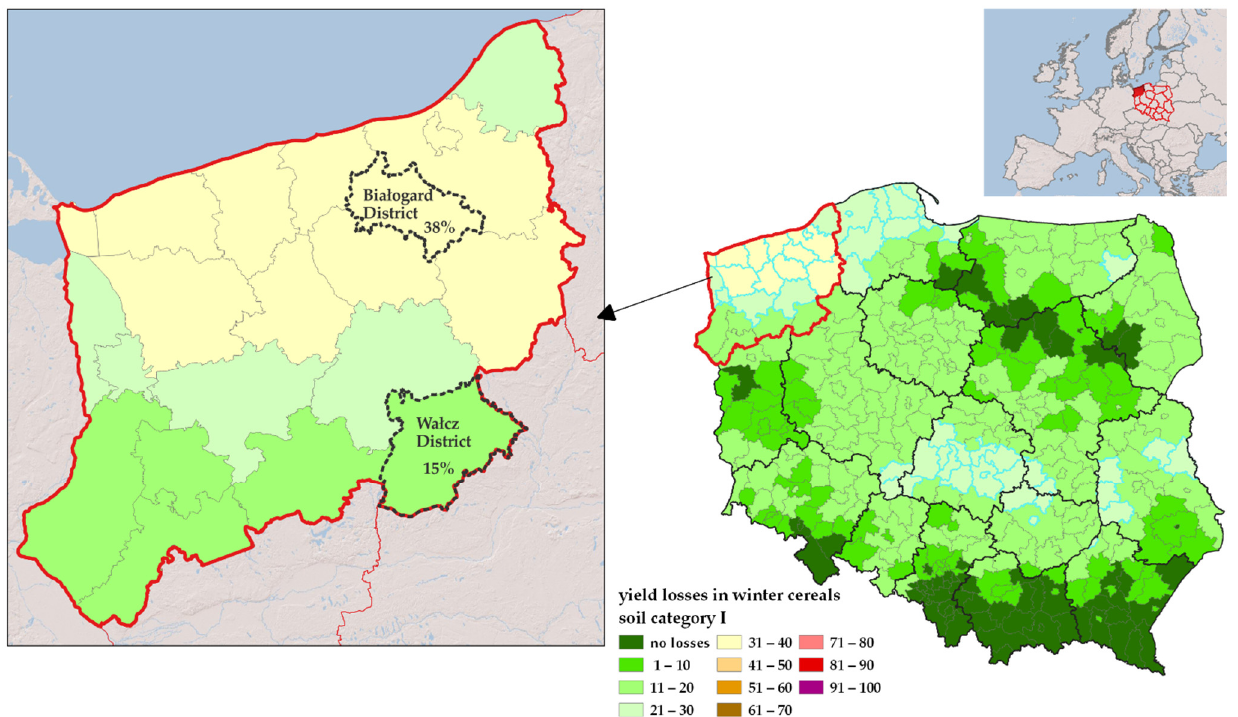
Figure 3. ADMS Map of estimated yield losses of winter cereals caused by drought—average losses on soils of the 1st category of susceptibility to drought for districts in 2021. The red arrow points to the Bia ł ogard district; the blue arrow points to the Wa ł ecki district. Source: own study (IUNG-PIB).